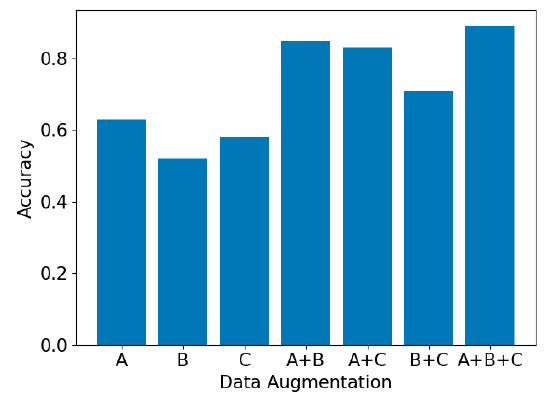
Figure 8. Multiple data augmentation methods.